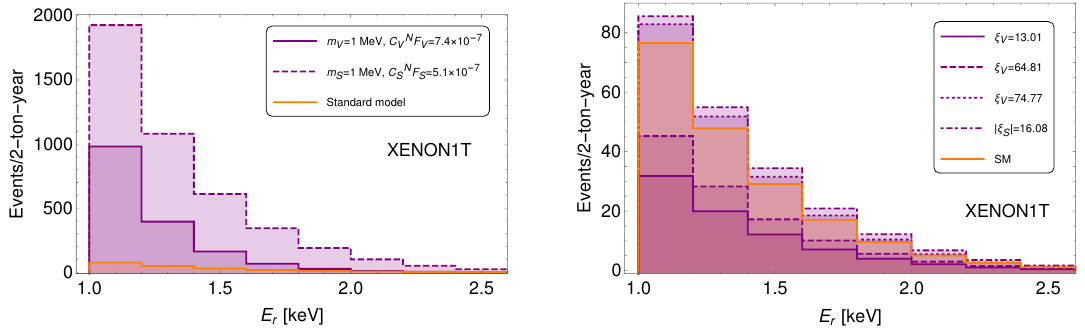
Figure 7 . Left graph : expected event rate spectrum for vector and scalar light mediators at XENON1T assuming a 2 ton-year exposure. Parameters are chosen to maximize the new physics event rate. Any other choice will therefore lead to events below these values. Right graph : expected event rate spectrum for vector and scalar e(cid:11)ective interactions. Results for LZ (10 ton-year) can be directly derived by rescaling these event rate spectrum by a factor 5. For comparison the SM expec- tation is also shown (orange histogram). These results demonstrate that low recoil threshold